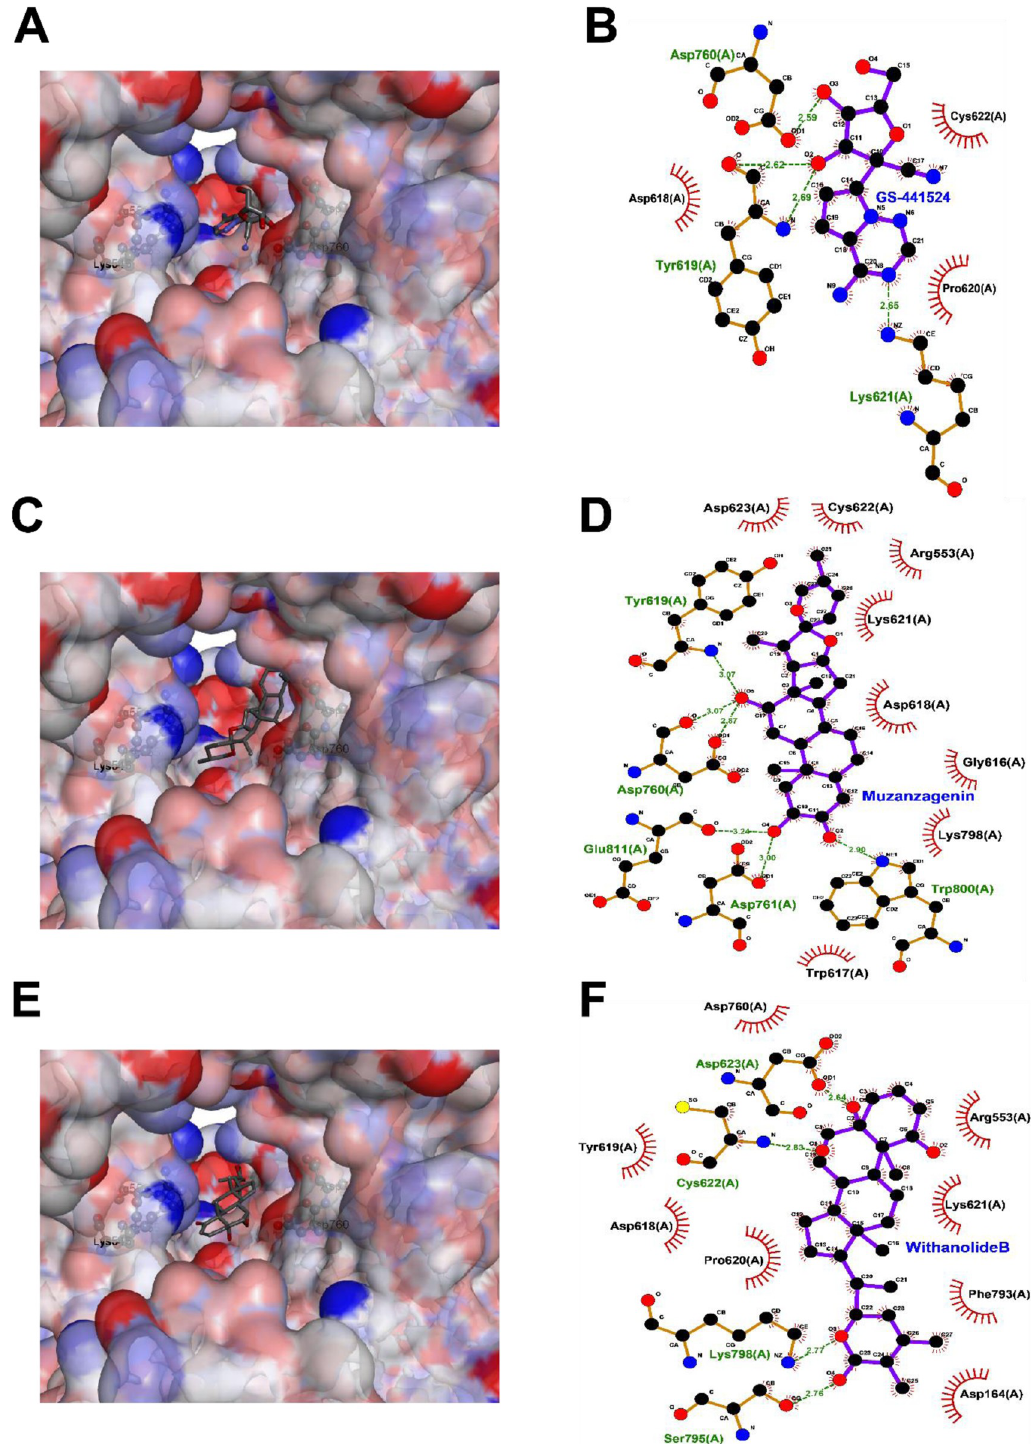
Fig 13. Interaction of (A and B) Remdesivir (C and D), Muzanzagenin and (E and F) Withanolide-B with RdRp. In the left panel the protein is shown in a surface representation colored by atom while the ligand is shown in stick representation. The right panel is a 2D interaction plot of the receptor with the